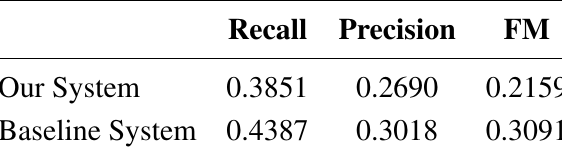
Table 2. Comparison of Clustering Results using Yahoo! News